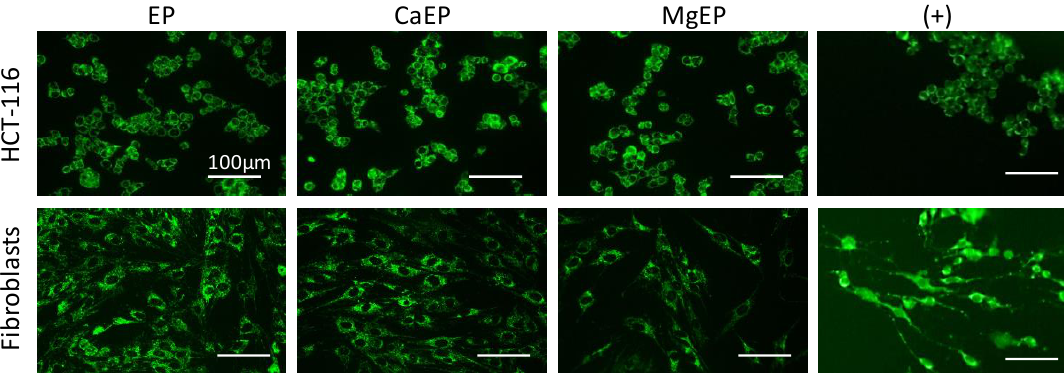
Figure 8. Immunofluorescent detection of cytochrome c 5 min after 5 mM calcium or magnesium electroporation in HCT-116 tumor cells and normal dermal fibroblasts. Punctiform labeling indicates that cytochrome c is sequestered into mitochondria. Indeed, in case of release, the signal is blurry and distributed throughout the cytoplasm, as shown in positive control conditions (+) representing cells incubated for 3 h with 50 µM staurosporine. Pictures are representative of two independent experiments.